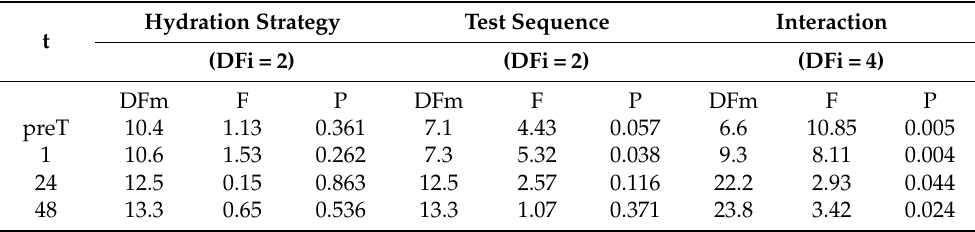
Figure 8. C-reactive protein mean values estimated by the least squares method with upper and lower confidence intervals for four measurements [mg · mL − 1 ]. Table 17. Results of analysis of variance for CRP measured before the test (preT) and 1, 24, and 48 h after the exercise test: significance of (P) and F-statistic along with the number of degrees of freedom (DFi—in the numerator; DFm—in the denominator) for the fixed effects (hydration strategy, test sequence, and their